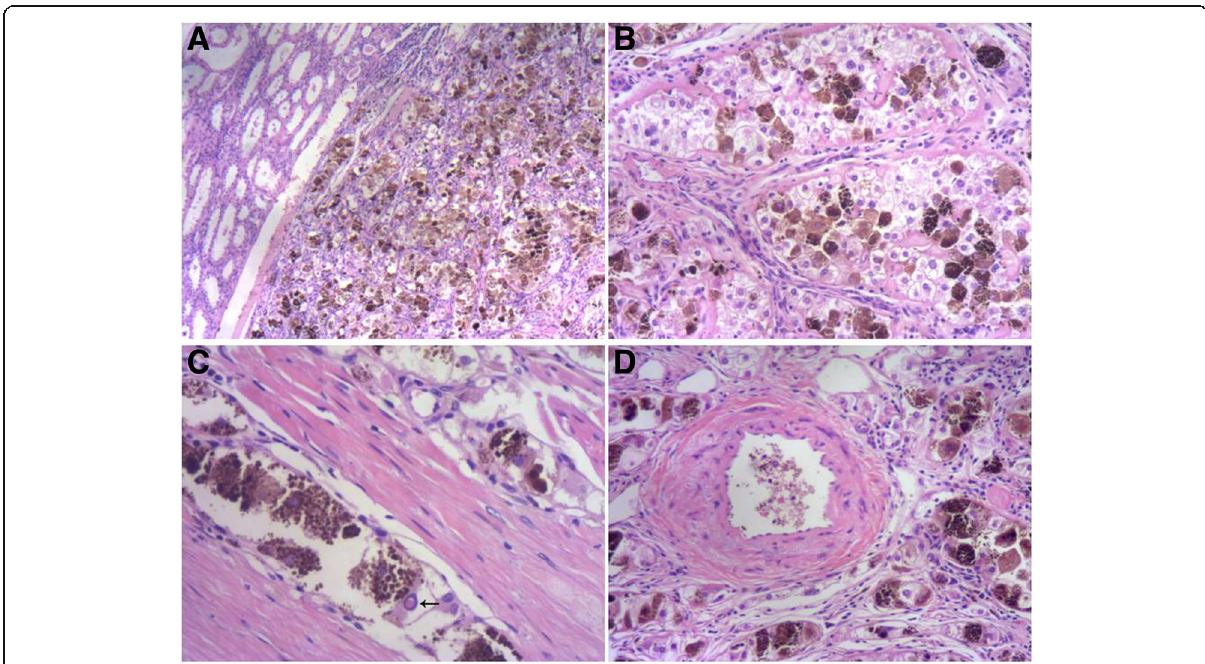
Fig. 2 a The non-encapsulated tumor was sharply demarcated from the adjacent renal parenchyma (H&E staining, × 40). b The neoplasm consisted of polygonal tumor cells with clear and granular cytoplasm arranged in nests and cords delimited by thin-walled fibrovascular septa